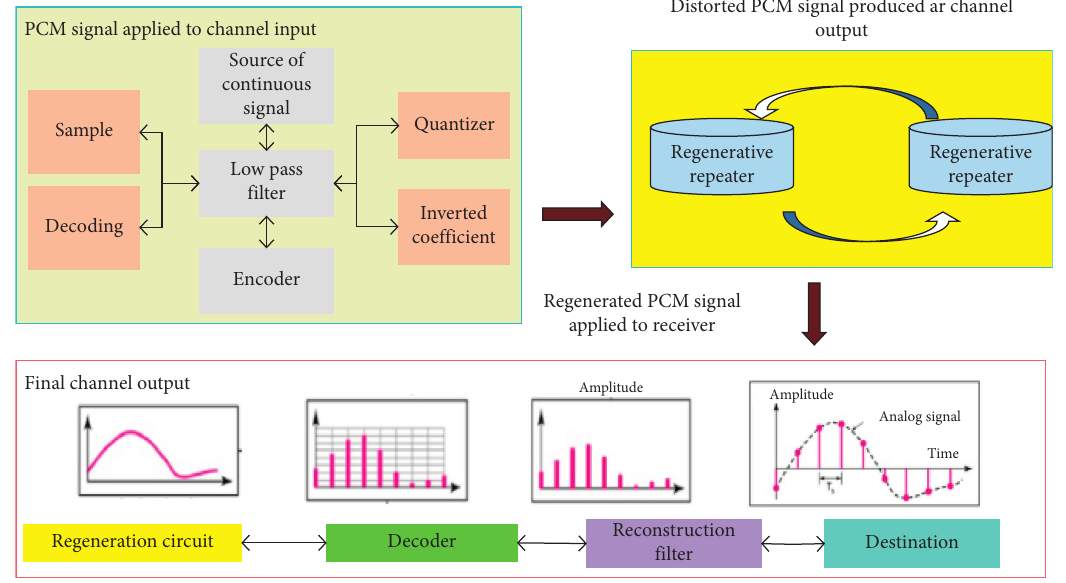
Figure 1: Excitation